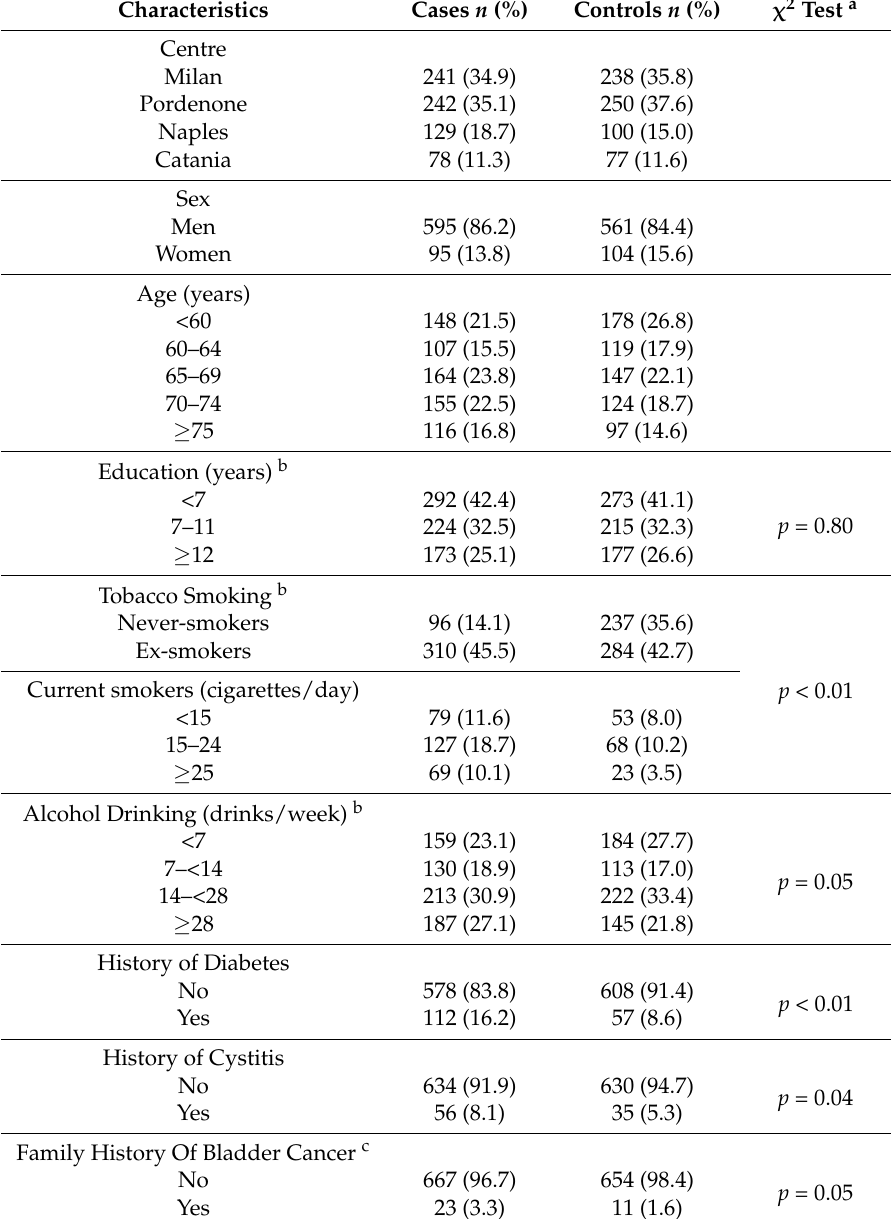
Table 1. Distribution of 690 cases of bladder cancer and 665 controls according to age, sex, education, and other selected variables. Italy,